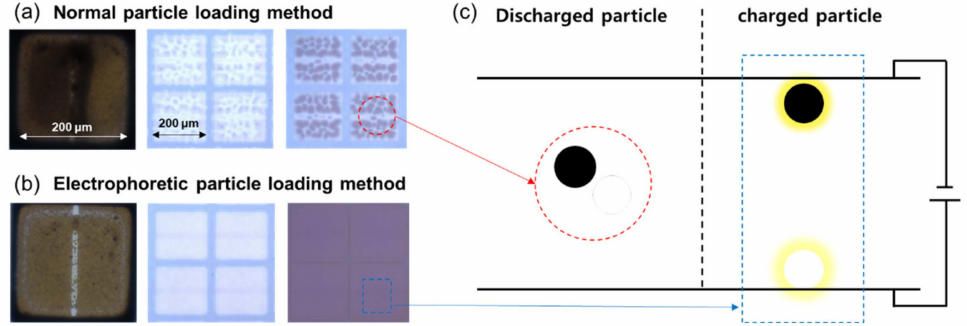
Figure 4. Optical microscopy images for E-paper fabricated by ( a ) conventional particle loading method and ( b ) electrophoretic particle loading method. ( c ) Schematic illustration for comparison of discharged and charged particles in the